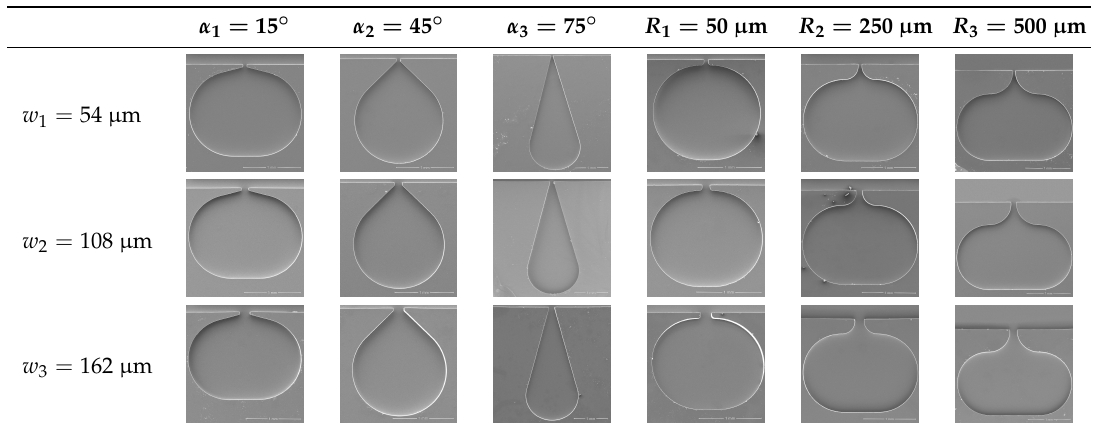
Table 1. Shape parameters considered for the 18 pressure tap